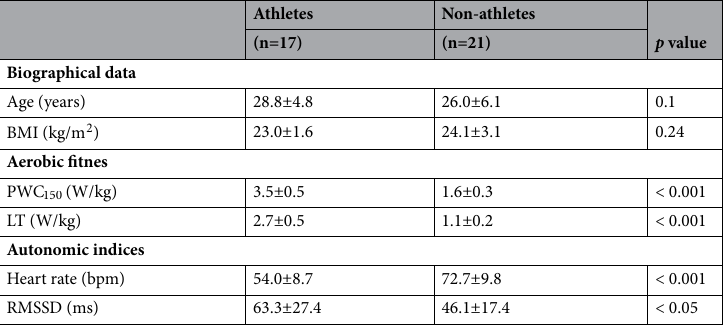
Table 1. Demographic and physiological data. p values are given for group comparisons using Mann-Whitney U test. BMI—body mass index, PWC 150 —physical work capacity during a heart rate of 150 (watt per kg